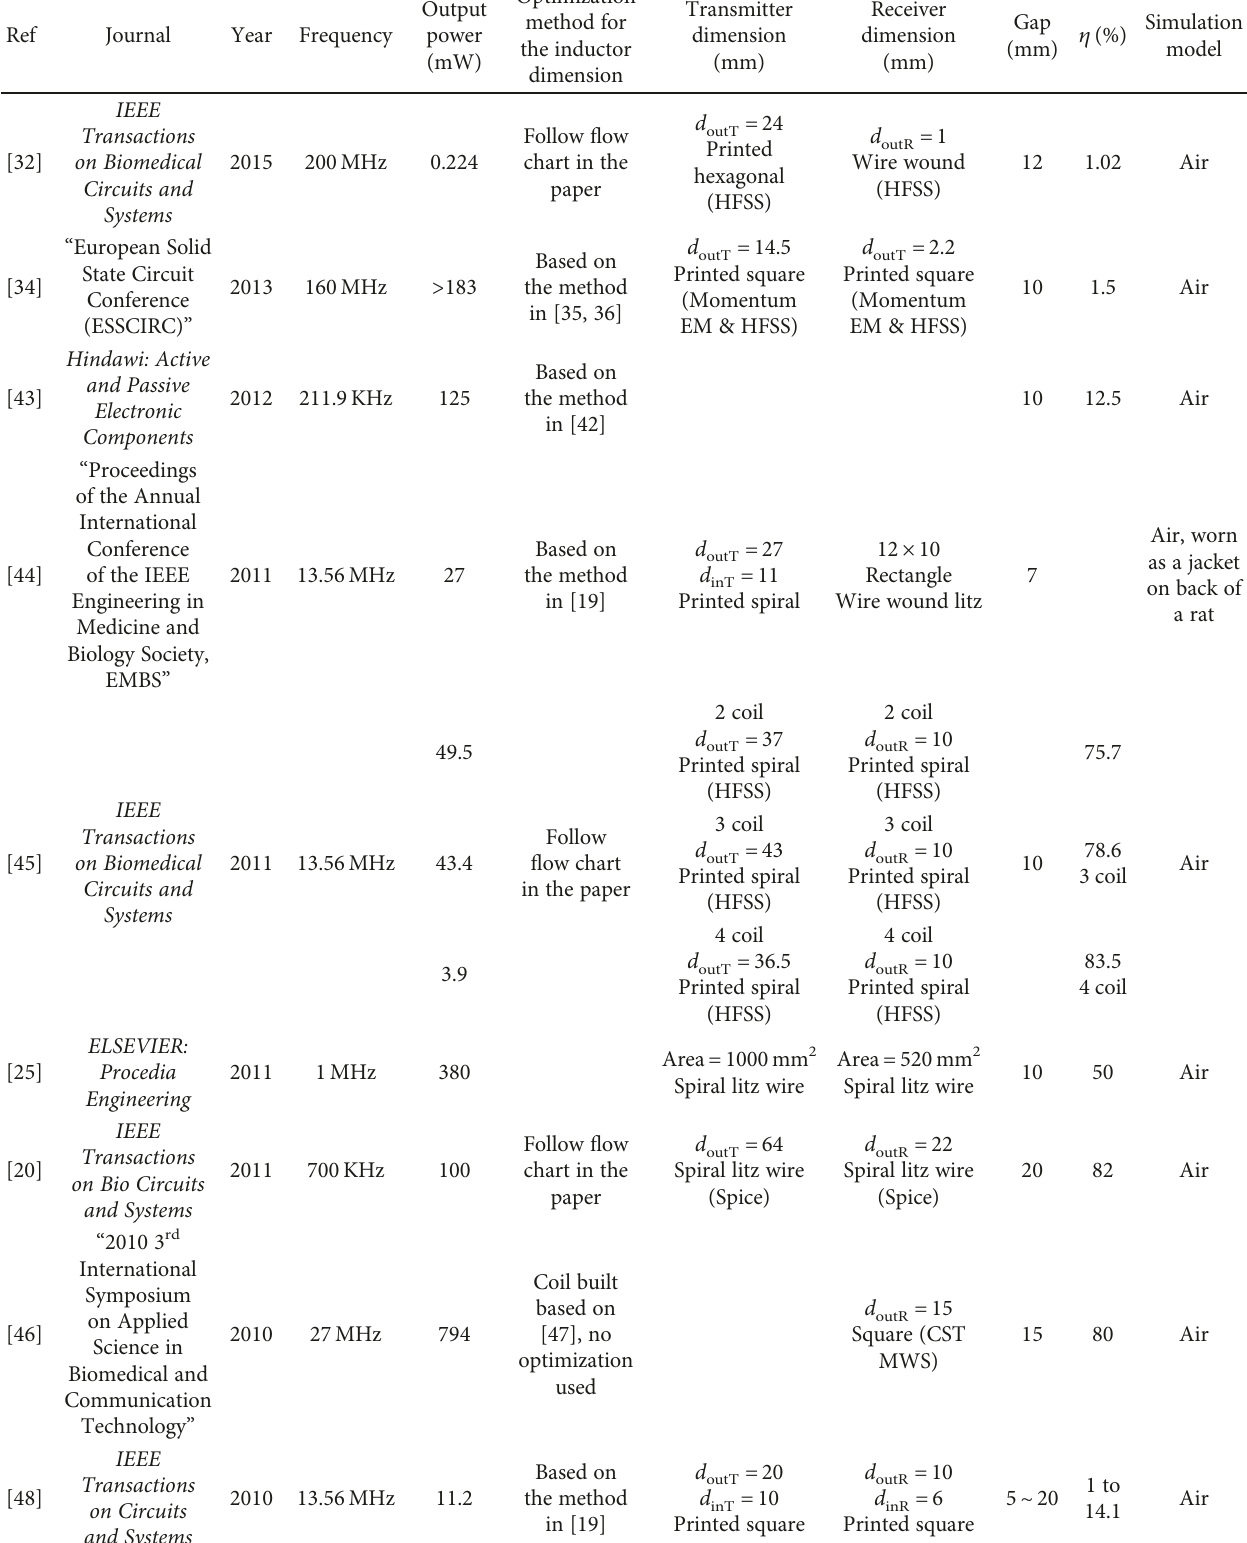
Table 3: Implantable power device modeled in